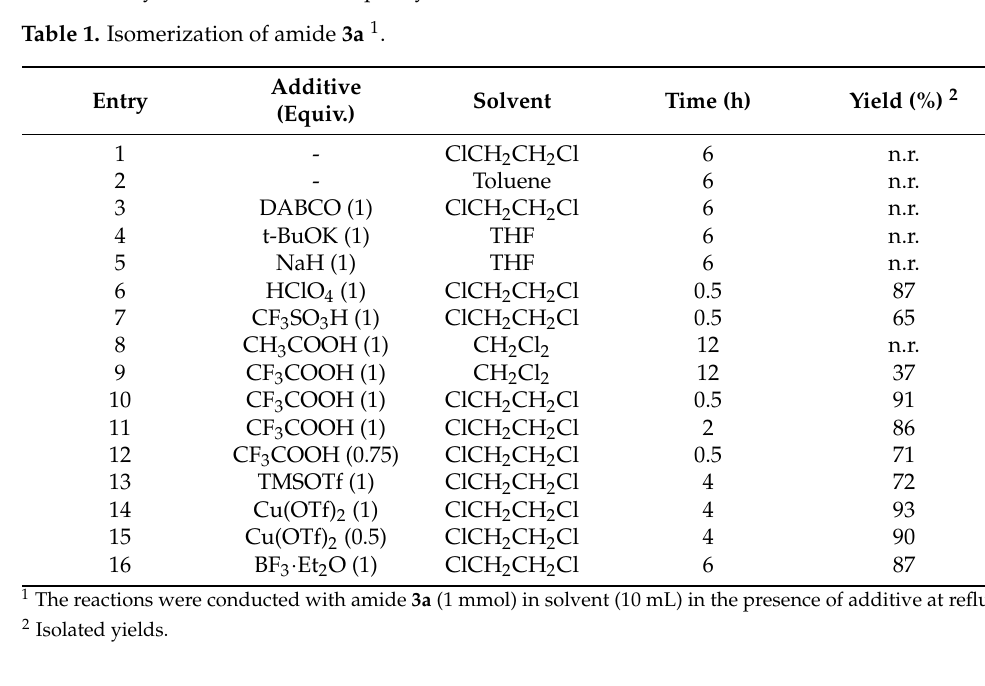
Table 1. Isomerization of amide 3a 1 .